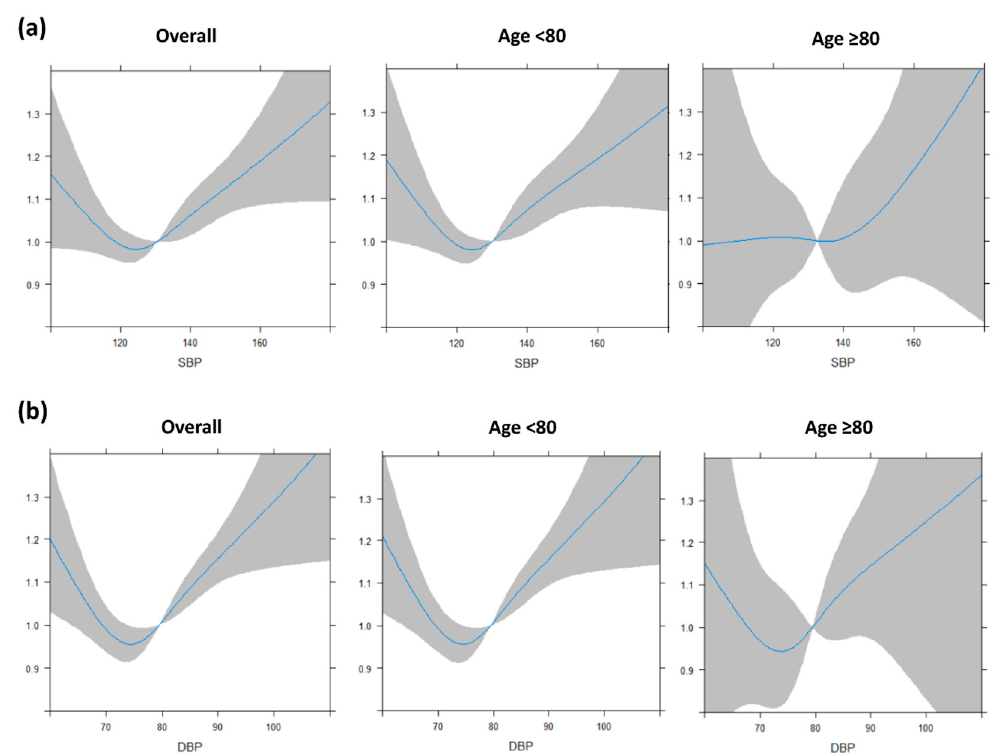
Figure 2. Systolic and diastolic blood pressure status of repeated measurement and risk of atrial fibrillation among elderly populations: ( a ) systolic blood pressure and ( b ) diastolic blood pressure. SBP, systolic blood pressure; DBP, diastolic blood pressure. The blue line shows relationship between hazard ratio of new-onset AF and blood pressure, and the gray area indicates the degree of confidence.